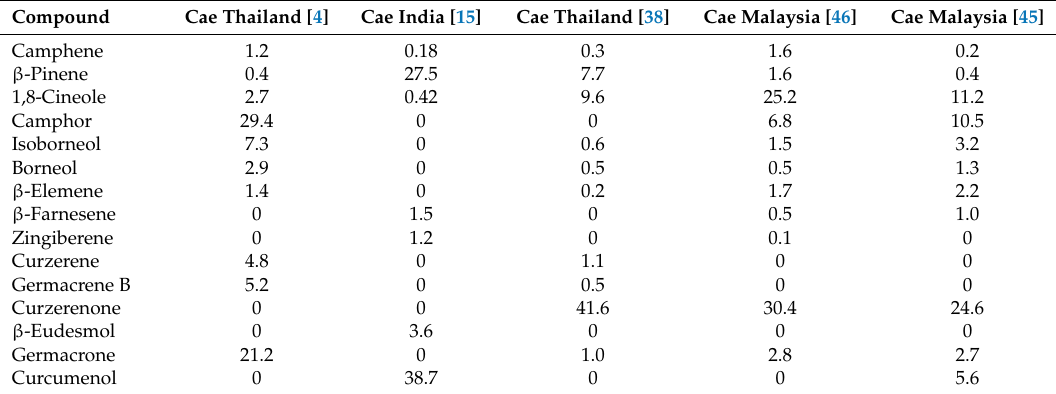
Table 4. Chemical composition of Curcuma aeruginosa rhizome essential oils reported in the literature.